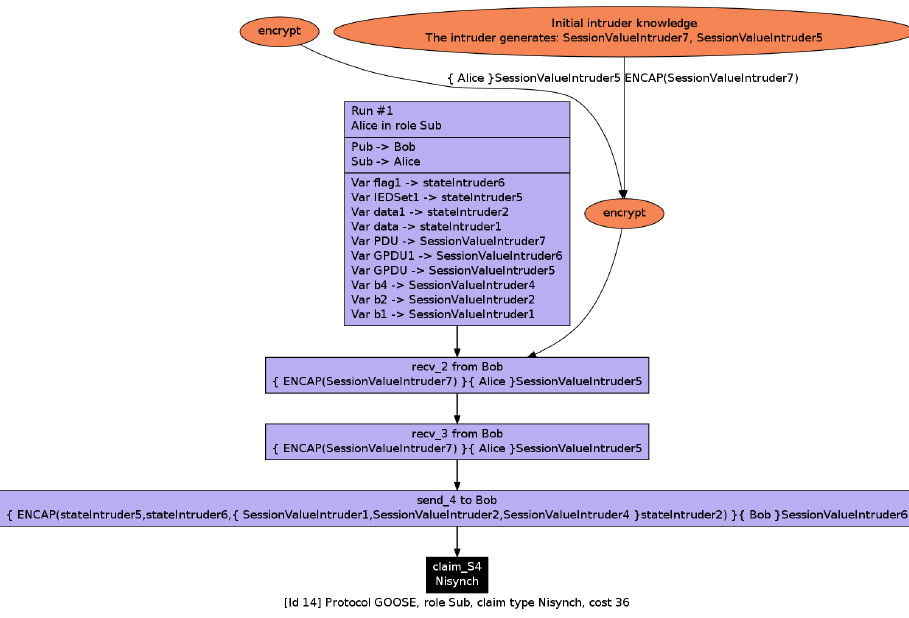
Figure 9. Attack on subscriber to compromise the Nisynch security